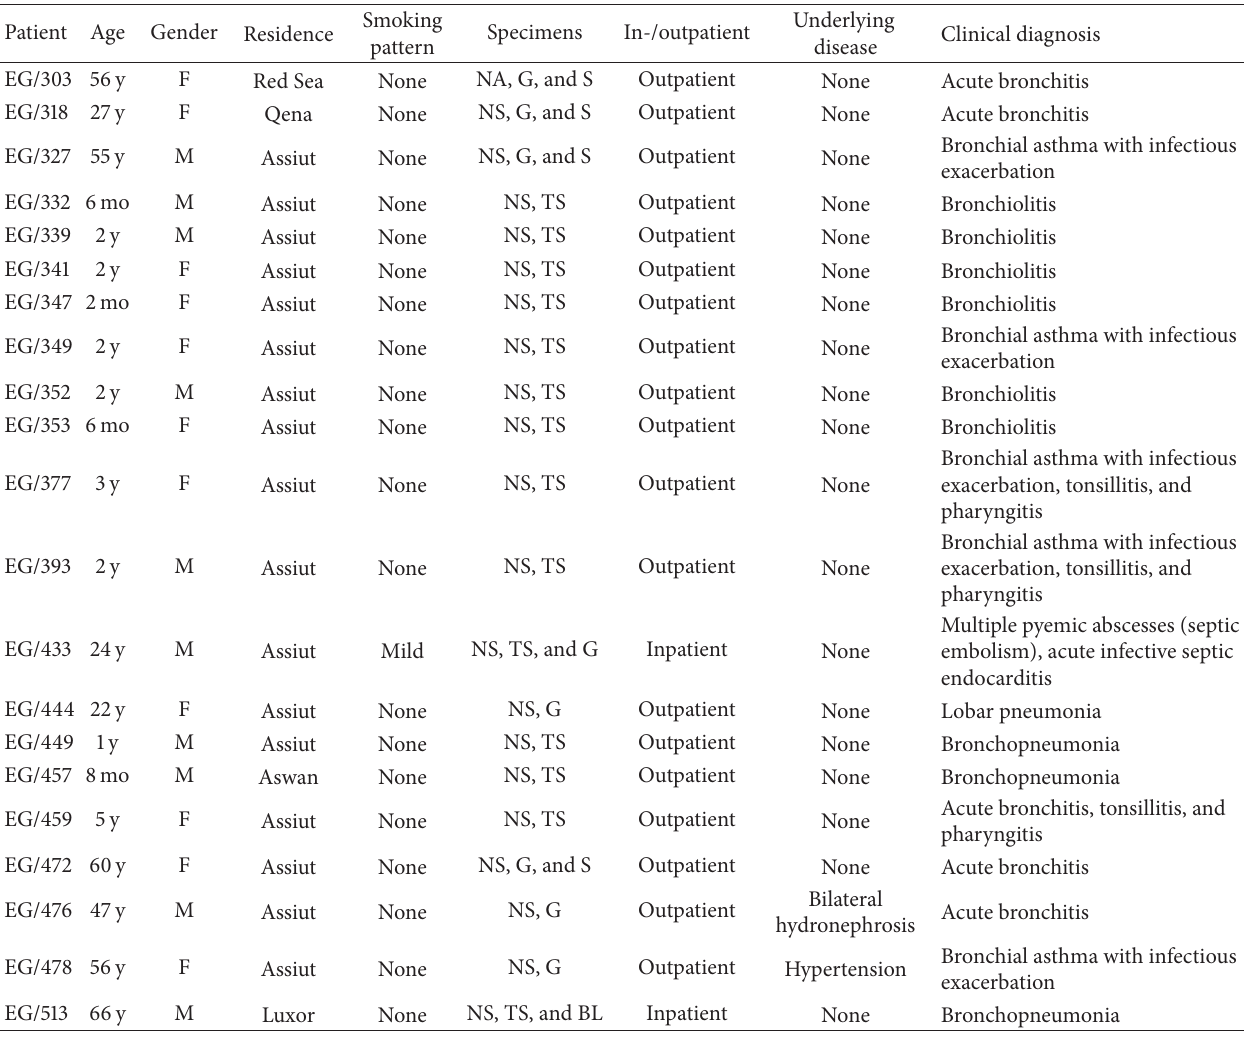
Table 4: Clinical characteristics of HMPV